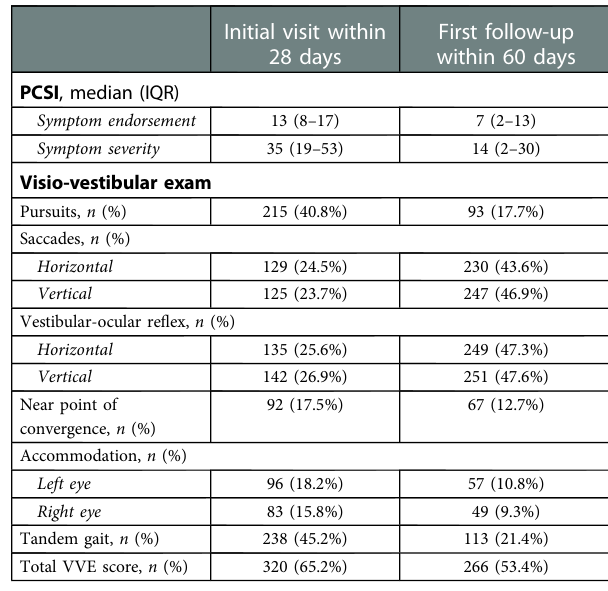
TABLE 2 Clinical exam outcomes of all patients at initial visit and fi rst